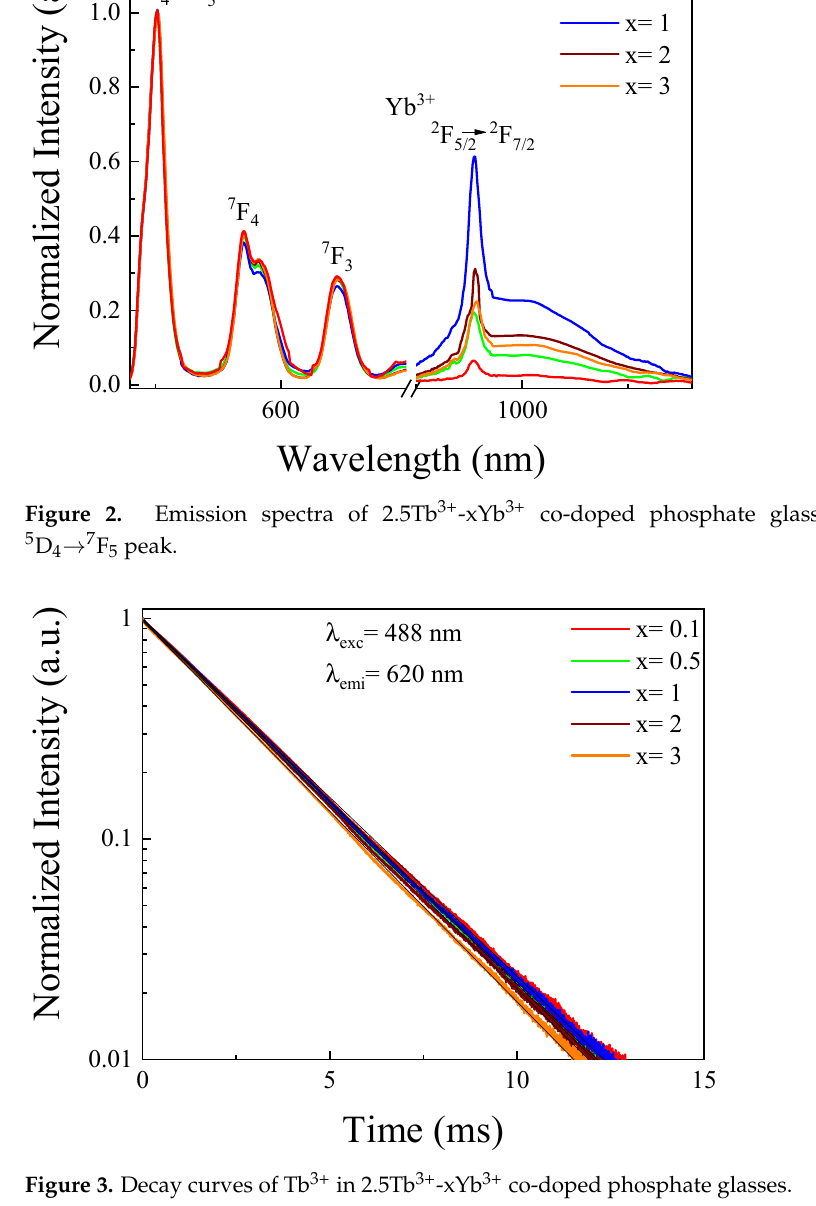
Figure 2. Emission spectra of 2.5Tb 3+ -xYb 3+ co-doped phosphate glasses normalized to 5 D 4 → 7 F 5 peak.